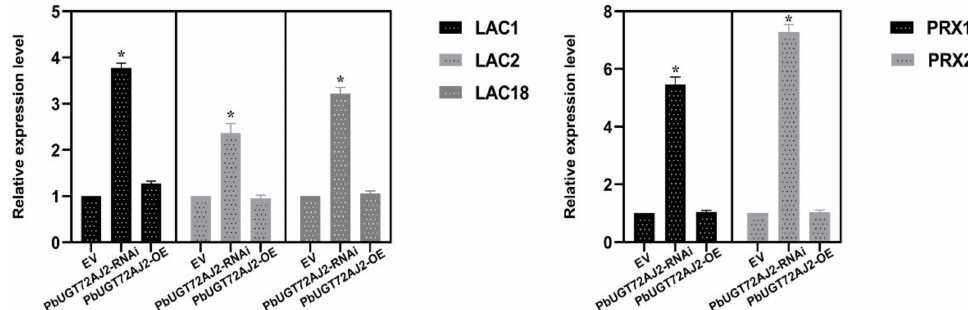
Figure 7. RT-qPCR confirmed the activation of genes ( LAC and PRX ) responsible for secondary wall biosynthesis in PbUGT72AJ2-RNAi and PbUGT72AJ2-OE . EV: empty vector. * p < 0.05. Error bars represent the standard (SE) of three biological